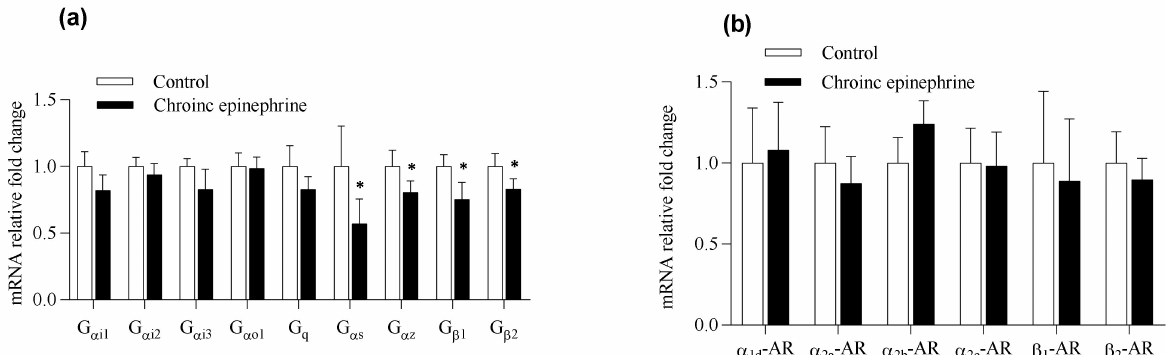
Figure 6. Expression levels in isolated pancreatic islets. The relative fold changes of of ( a ) G protein subunits and ( b ) adrenergic receptors are from Epi rats ( n = 6) and controls ( n = 7). G α i1-3 , G α o1 , G q , G α s , G α z and G β 1-2 , G protein subunits; AR, adrenergic receptor.